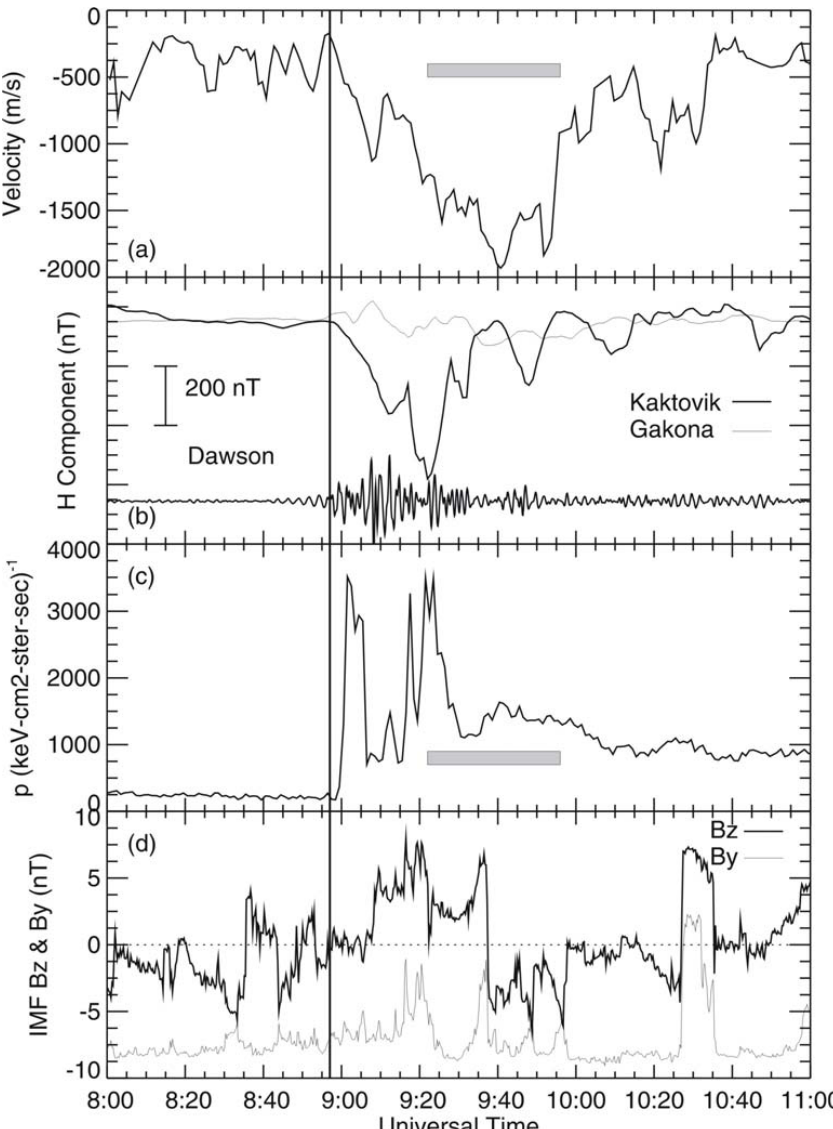
Figure 5. Summary of the data for the 5 December 2001 event: (a) maximum velocity along the King Salmon HF radar beam 1 (the shaded bar indicates the period for which the high-velocity echo blob was seen on Fig. 4), (b) H-component of magnetic perturbations at Kaktovik and Gakona and Pi2 magnetic pulsations at Dawson (the length of the vertical scale bar corresponds to 33nT for this trace), (c) flux of energetic protons according to measurements by the geostationary satellite LANL 1991-080 and (d) IMF B z and B y components. Vertical line indicates the substorm onset.